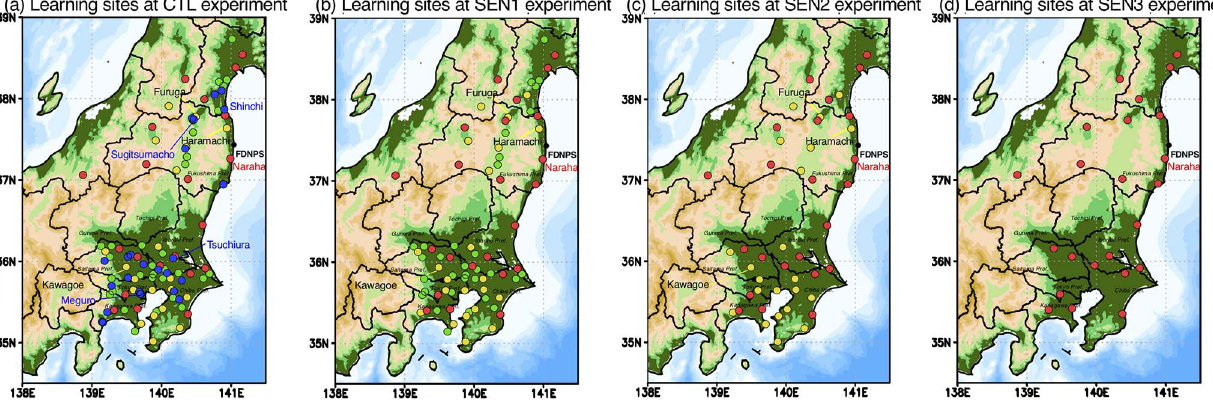
Figure 1. Cs-137 observation sites used as a learning site in (a) the standard (CTL), (b) SEN1, (c) SEN2 and (d) SEN3 experiments in this study. The closed black circle is the location of the FDNPS. The closed circles in red, yellow, green and blue are the locations of the learning data sites used in the CTL experiment. The closed circle in yellow is the learning data location used for the ensemble in CTL, SEN1 and SEN2. The closed circle in green is the learning data location used for the ensemble in CTL and SEN1. The closed circle in blue is the learning data location used for the ensemble in the CTL only. The number of sites is 23 (red), 22 (yellow), 32 (green) and 24 (blue). The details are also explained in Table 3. The words in italics are the names of prefectures. The Kant¯o region includes seven prefectures: Tokyo, Kanagawa, Chiba, Saitama, Ibaraki, Tochigi and Gunma. The background map for the elevation is obtained from the ETOPO (Amante and Eakins, 2009). Table 3. Test experiments in the ensemble method using the selected sites.